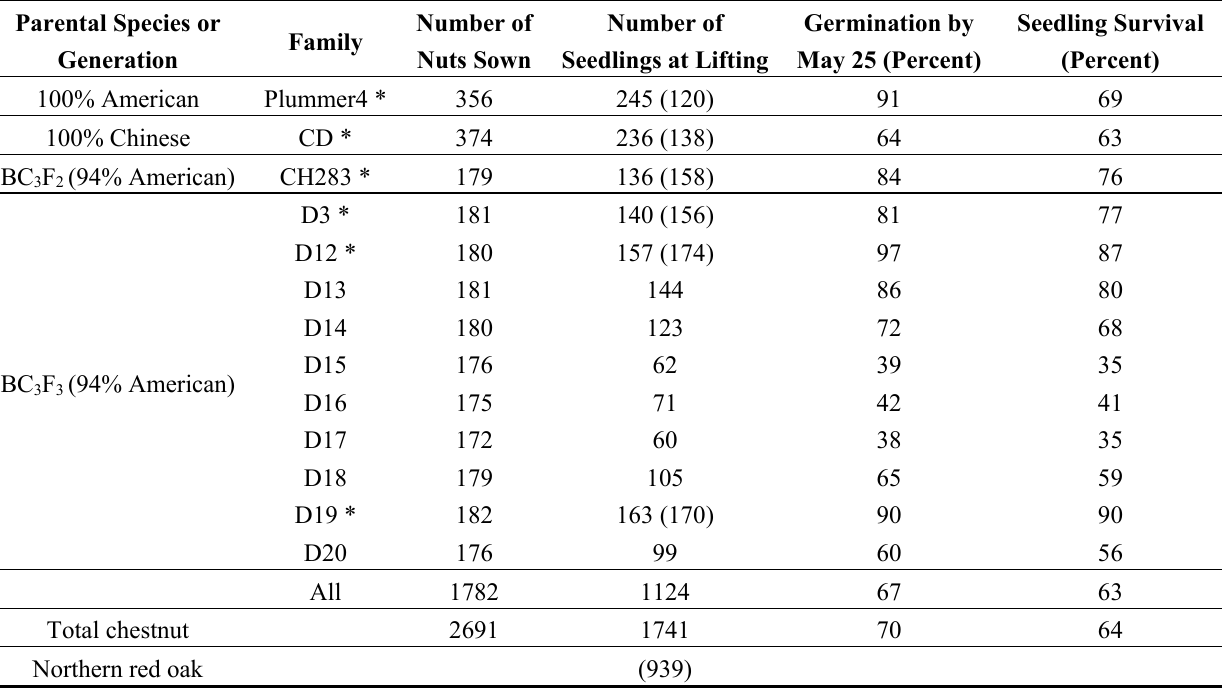
Table 1. Number of chestnut nuts sown and seedlings lifted within each parental species, breeding generation, and family. All chestnut families were used in the nut weight and growth and germination patterns experiments. Families noted with an asterisks (*) were used in the seasonal growth patterns study and counts in parentheses are the number of seedlings used in the seasonal growth patterns study at the date of the last measurement before